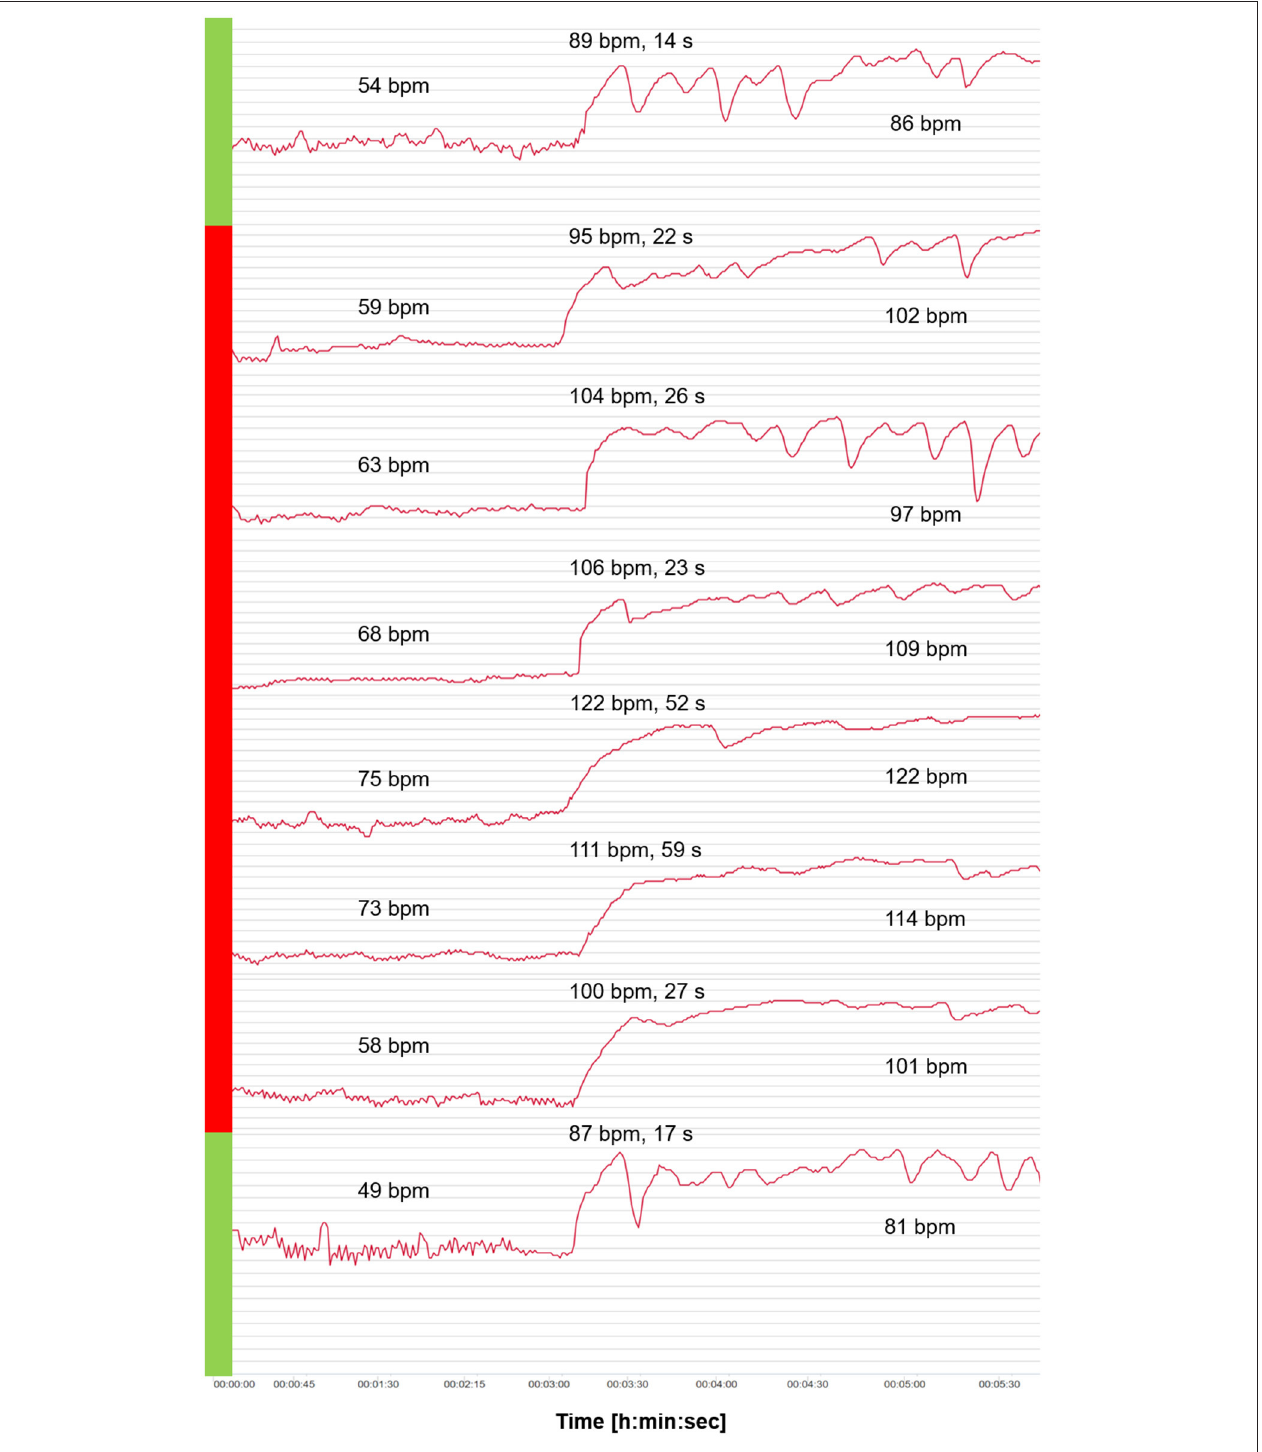
FIGURE 3 | Heart rate (HR) curves from the orthostatic test (OT) for the 6-day viral infection period (red) and a curve before and after the viral infection period (green). Mean values of HR analyzed after 2min in the supine position, and HRpeak, tHRpeak, and mean values of HR analyzed after 2min in the standing position.